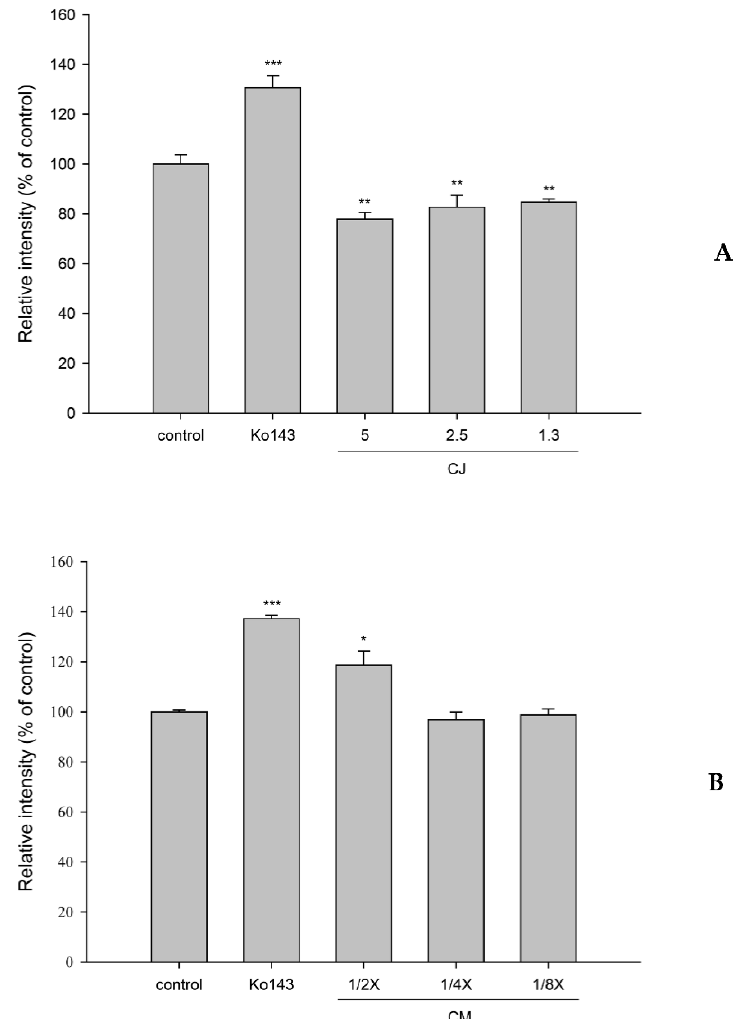
Figure 4. Effects of cranberry juice (CJ, mg/mL) ( A ) and serum metabolites of cranberry (CMs, at one half, one quarter and one eighth of the serum concentrations) ( B ) on the intracellular accumulation of MXR in MDCKII-BCRP cells. * p < 0.05, ** p < 0.01, and *** p < 0.001. Ko143: a positive control for the BCRP inhibitor.